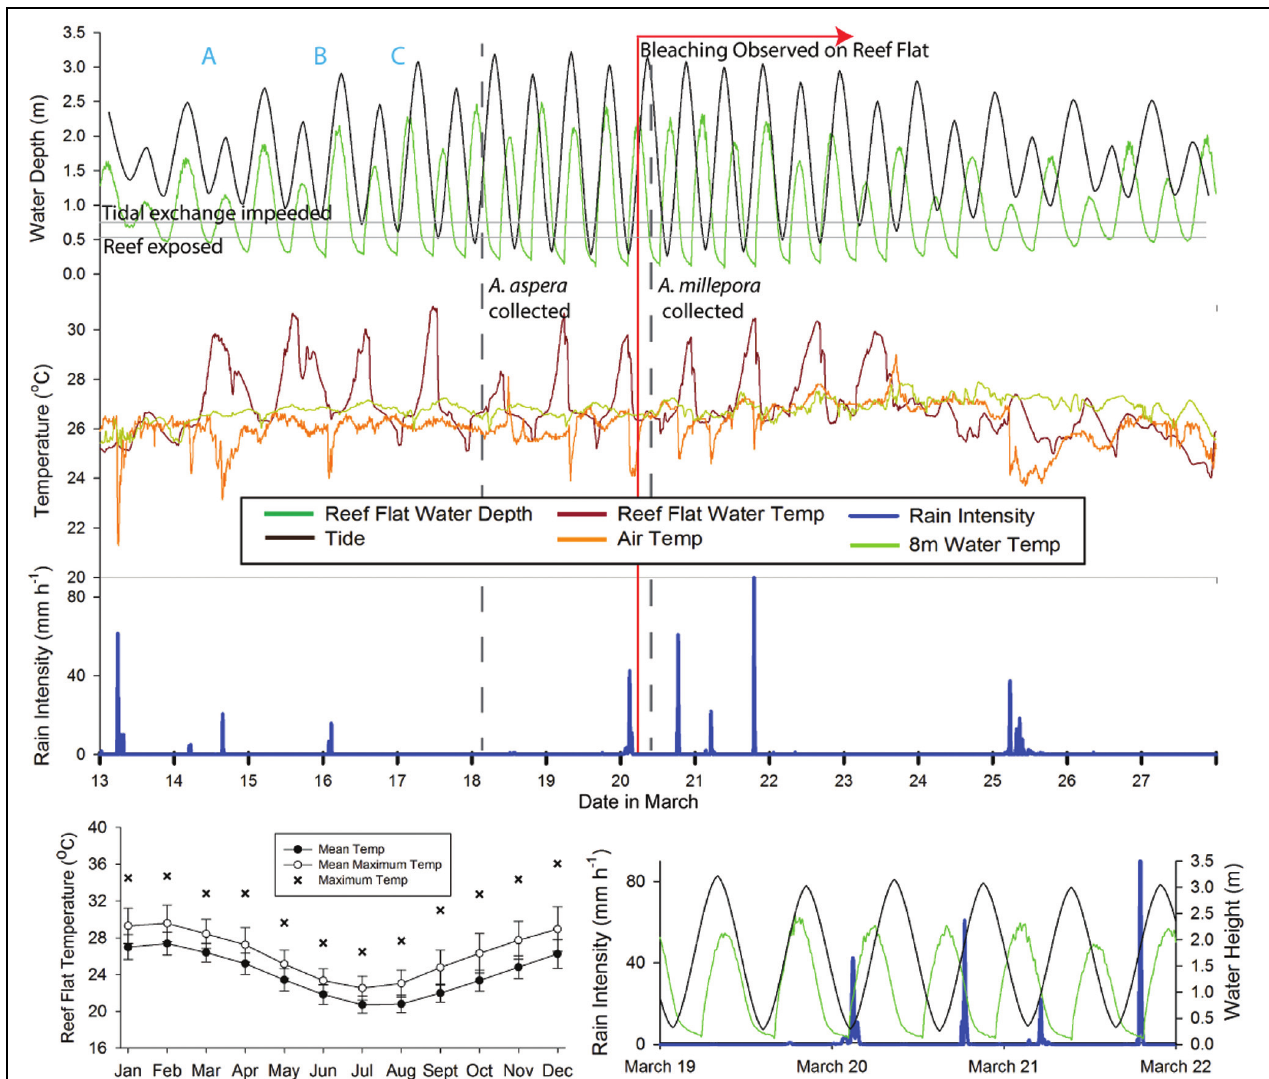
FIGURE 2 | Summary time line of conditions at the time of collection and observed bleaching at Heron Island. Upper composite graph generally indicates (from top to bottom) tide, temperature, and rain intensity. Tide is based on tide tables from the region (black line), with reef flat water depth (green line) as measured at the 1.1 m mooring present on the reef flat. Temperature is depicted as reef flat water depth (dark red line, measured at the 1.1 m water depth mooring), 8 m temperature (light green line, measured at the 7.9 m mooring), and air temperature (orange line). Key aspects of the temperature and tidal cycle (time points A, B and C in upper composite graph), the timing of coral collections (vertical dashed gray lines) and the authors’ first observation of mass bleaching on the reef flat (vertical red line) are also indicated. Lower right graph is a subset of information from the upper composite graph, highlighting the overlap between low tides on the reef flat (green line, measured at the 1.1 m water depth mooring), the tidal height (black line), and rainfall intensity (blue line). Air temperature and rain intensity were obtained from the local weather station on Heron Island. Lower left graph summarizes the mean temperature ( ± 1 SD) and mean maximum temperature ( ± 1 SD) and maximum temperature recorded at the reef flat (1.1 m water depth mooring) for the years 2008–2015. This figure is based on data provided by the Australian Institute of Marine